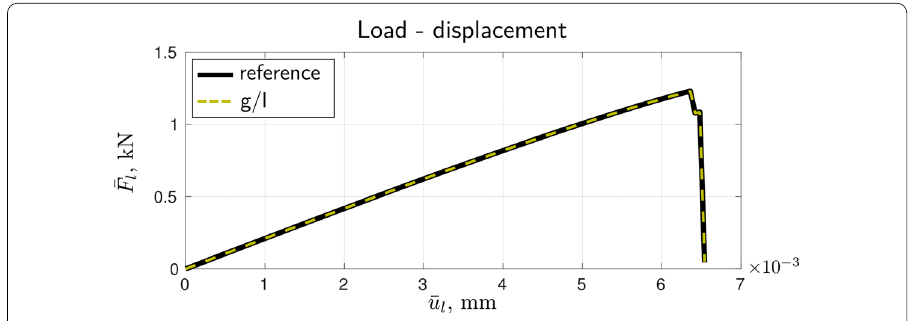
Fig. 7 Comparison of the load-displacement curves